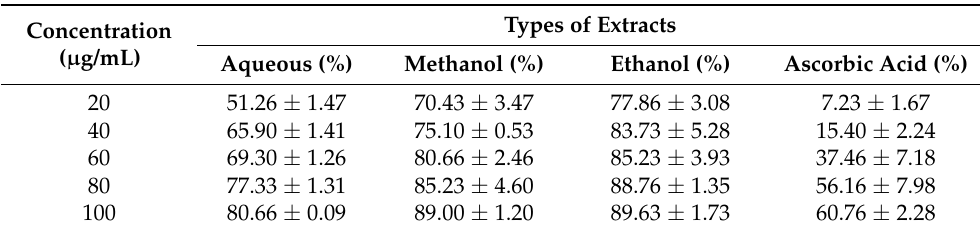
Table 3. DPPH analysis of different extracts of C. papaya leaves.